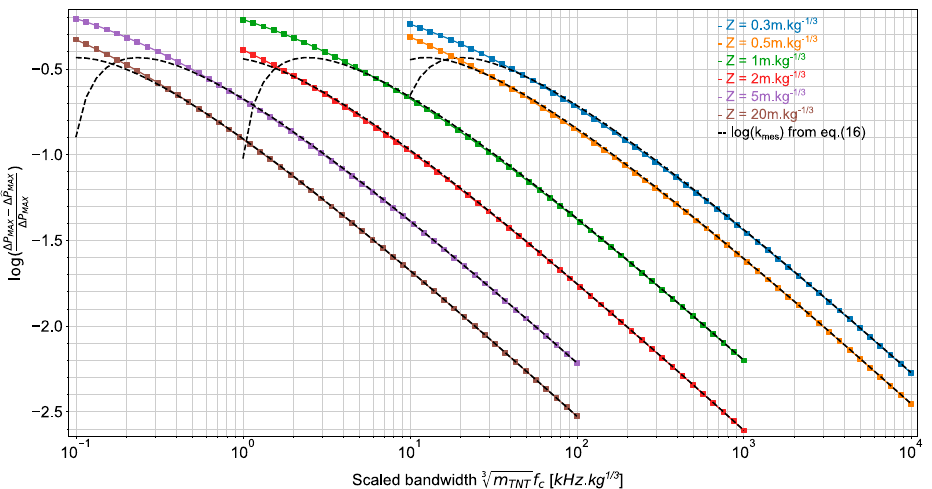
Figure 6. Estimation accuracy (∆𝑃 (cid:3014)(cid:3002)(cid:3025) − ∆𝑃(cid:3552) (cid:3014)(cid:3002)(cid:3025) ) ∆𝑃 (cid:3014)(cid:3002)(cid:3025) ⁄ on the overpressure peak as a function of the scaled bandwidth √ m TNT f c for various scaled distances. Results are obtained for the side-on overpressure measurement and surface bursts.